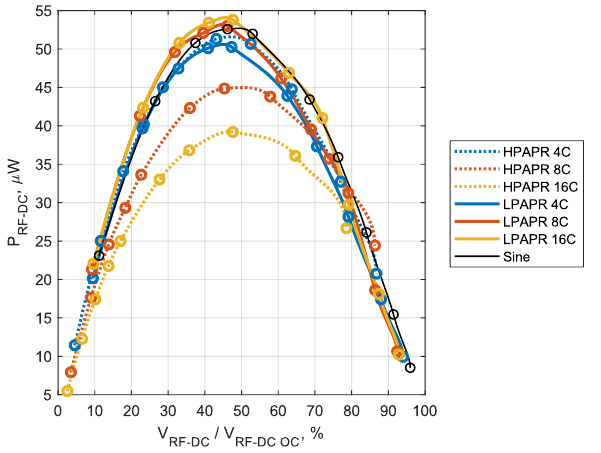
Fig. 6. RF-DC conversion output power levels for different MPPT levels.